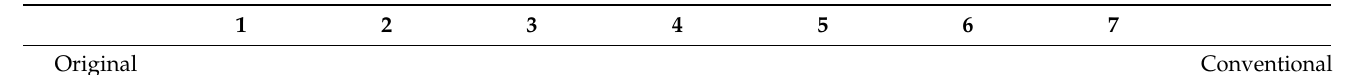
Table 2. UEQ concept valuation example